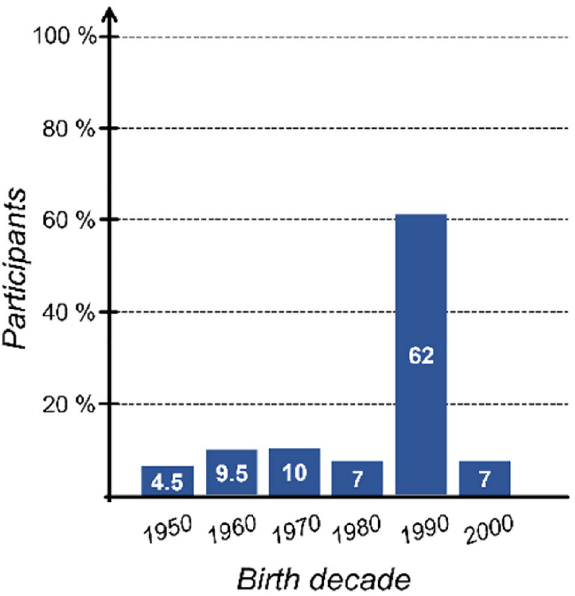
Figure 5. Survey participant classified by age.